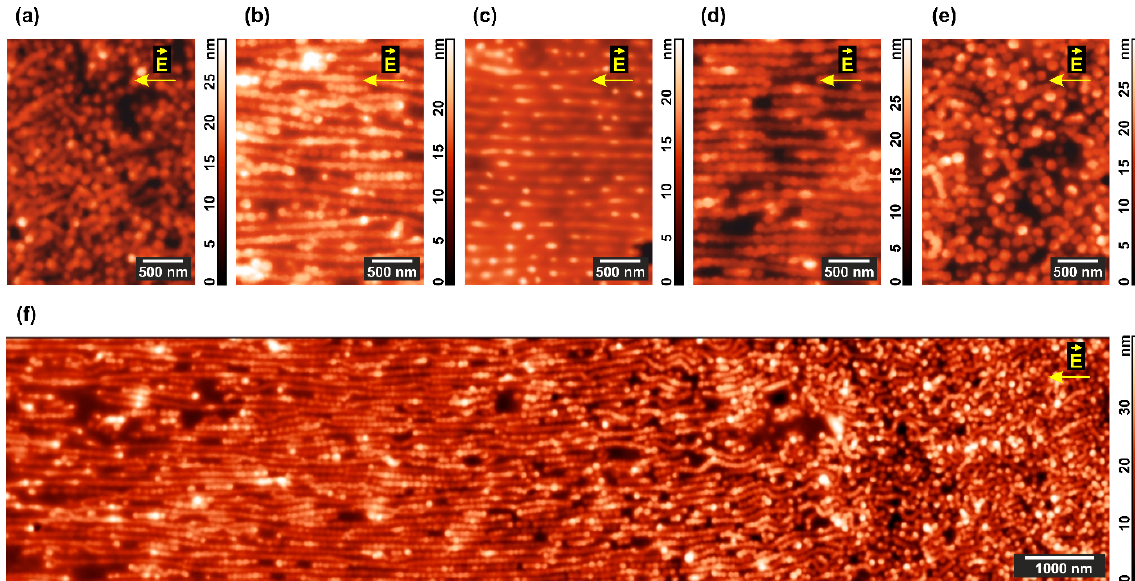
Figure 6. Domain structure of the microphase-separated PS–P4VP/AuNR film annealed under chloroform vapor and DC field. AFM images were taken from the ( a – e ) different internal areas on the way from cathode to anode and ( f ) large 15 μ m area situated closer to the anode.